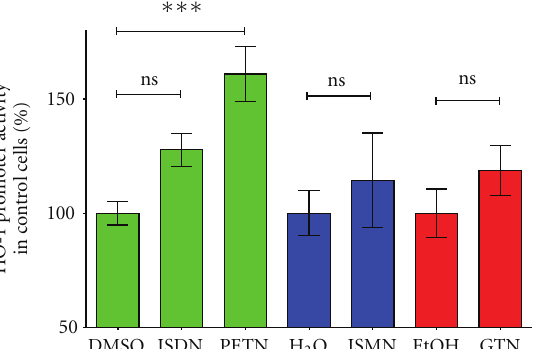
Figure 5: E ff ects of organic nitrates on the human HO-1 promoter activity. DLD1-HO-11kb-Prom cells were treated for 8 h with isosorbide dinitrate ISDN, PETN, isosorbide-5-mononitrate ISMN, or GTN at a concentration of 50 μ M or the respective solvent (DMSO, H 2 O, EtOH). Extracts were prepared, and luciferase activity and protein content were measured, and luciferase activity was normalized to the protein content. Shown (mean ± SEM; n = 8–10) are the normalized luciferase activity values. The normalized luciferase activity of the cell treated with solvent was set to 100%. ( ∗∗∗ = P < 0 . 001, ns: not significant di ff erent from solvent-treated cells.) These data were partly published in